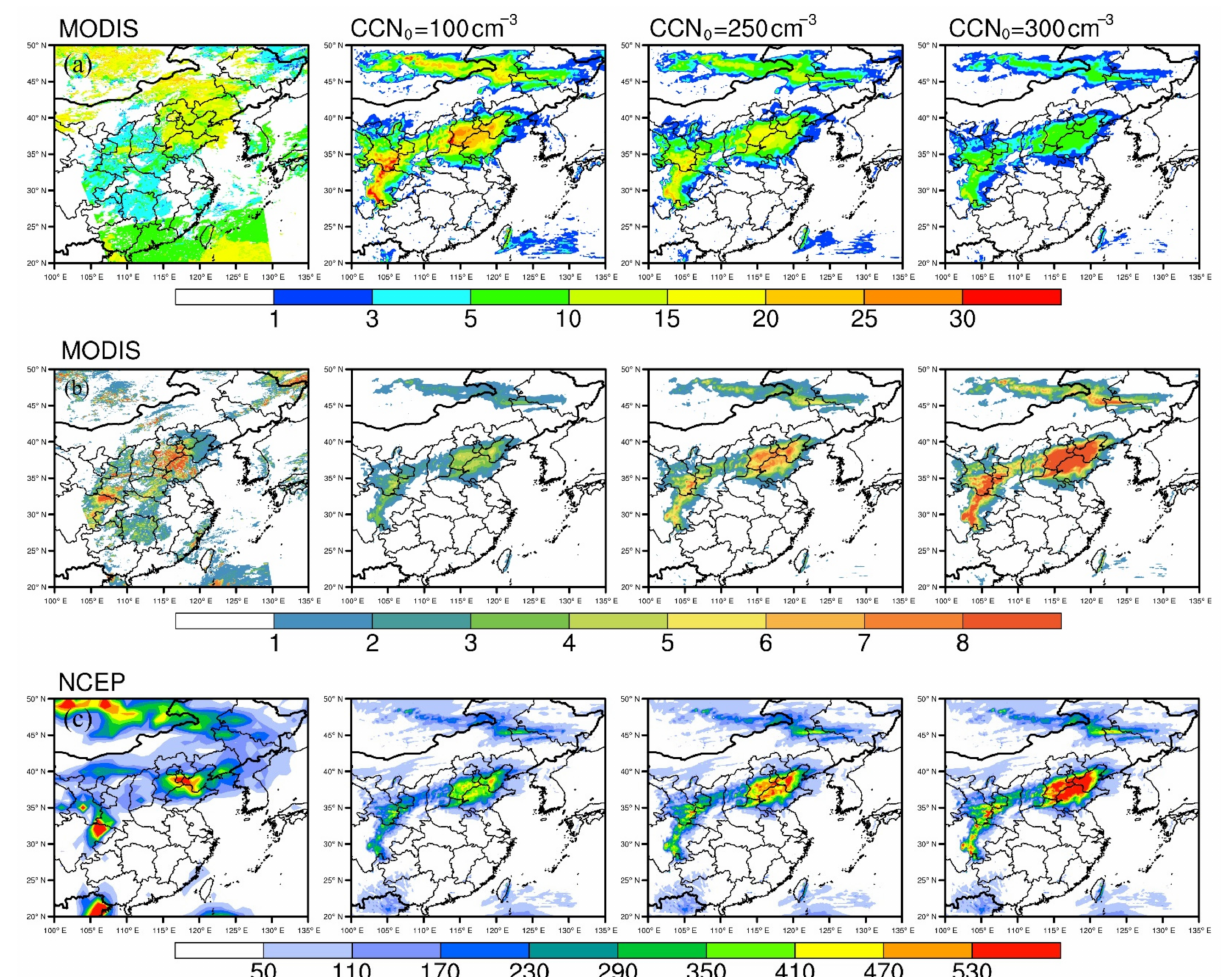
Figure 1. Averaged effective radius of cloud water (Rc) ( a ) ( µ m), cloud optical depth (COD) ( b ), and simulated cloud liquid water path (CLWP) ( c ) (g m − 2 ) (initial CCN number concentration (CCN 0 ) was set as 100, 250, and 300 cm − 3 in Morrison scheme) by model and Moderate Resolution Imaging Spectroradiometer (MODIS) Rc, COD, and National Center for Meteorological and Environmental Forecast (NCEP) analysis CLWP from 8 to 12 October